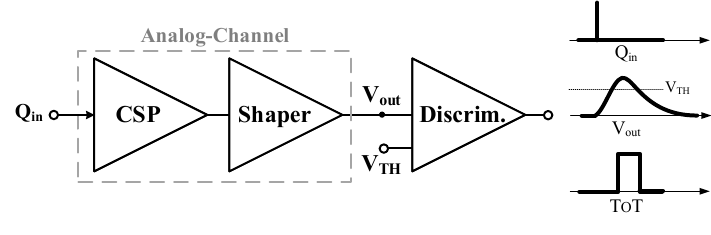
Figure 1. A typical structure of a TI-ToT read-out-channel.